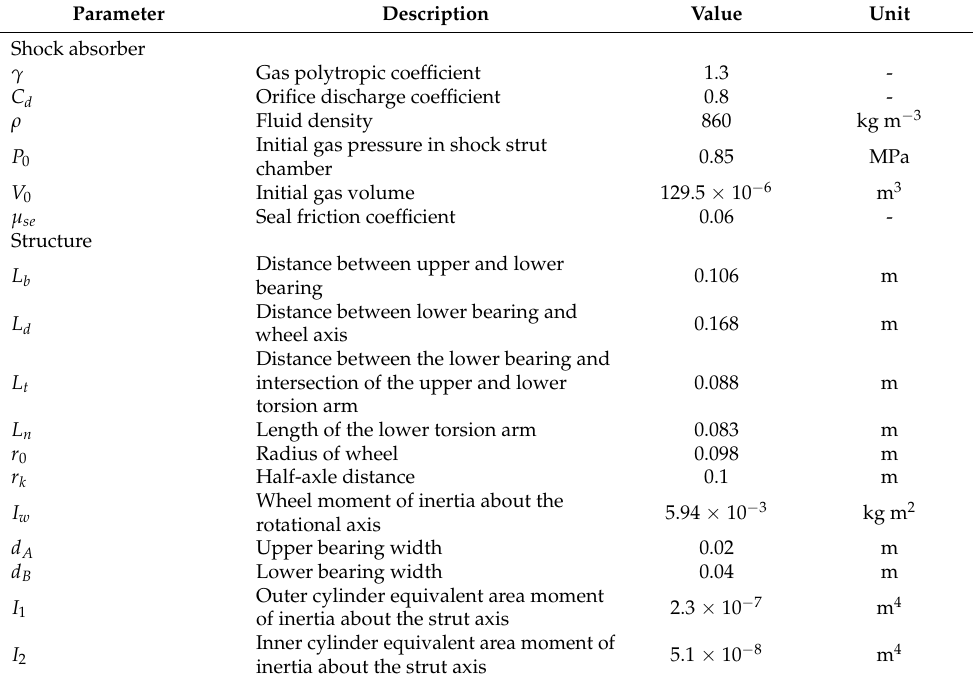
Table 2. Landing gear parameters definition and value.